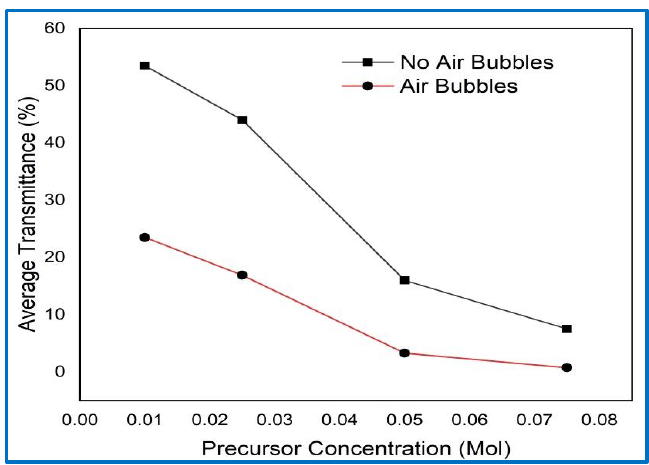
Figure 12. Precursor concentration versus average transmittance of synthesized ZnO nanorods in the presence and absence of air bubbles.